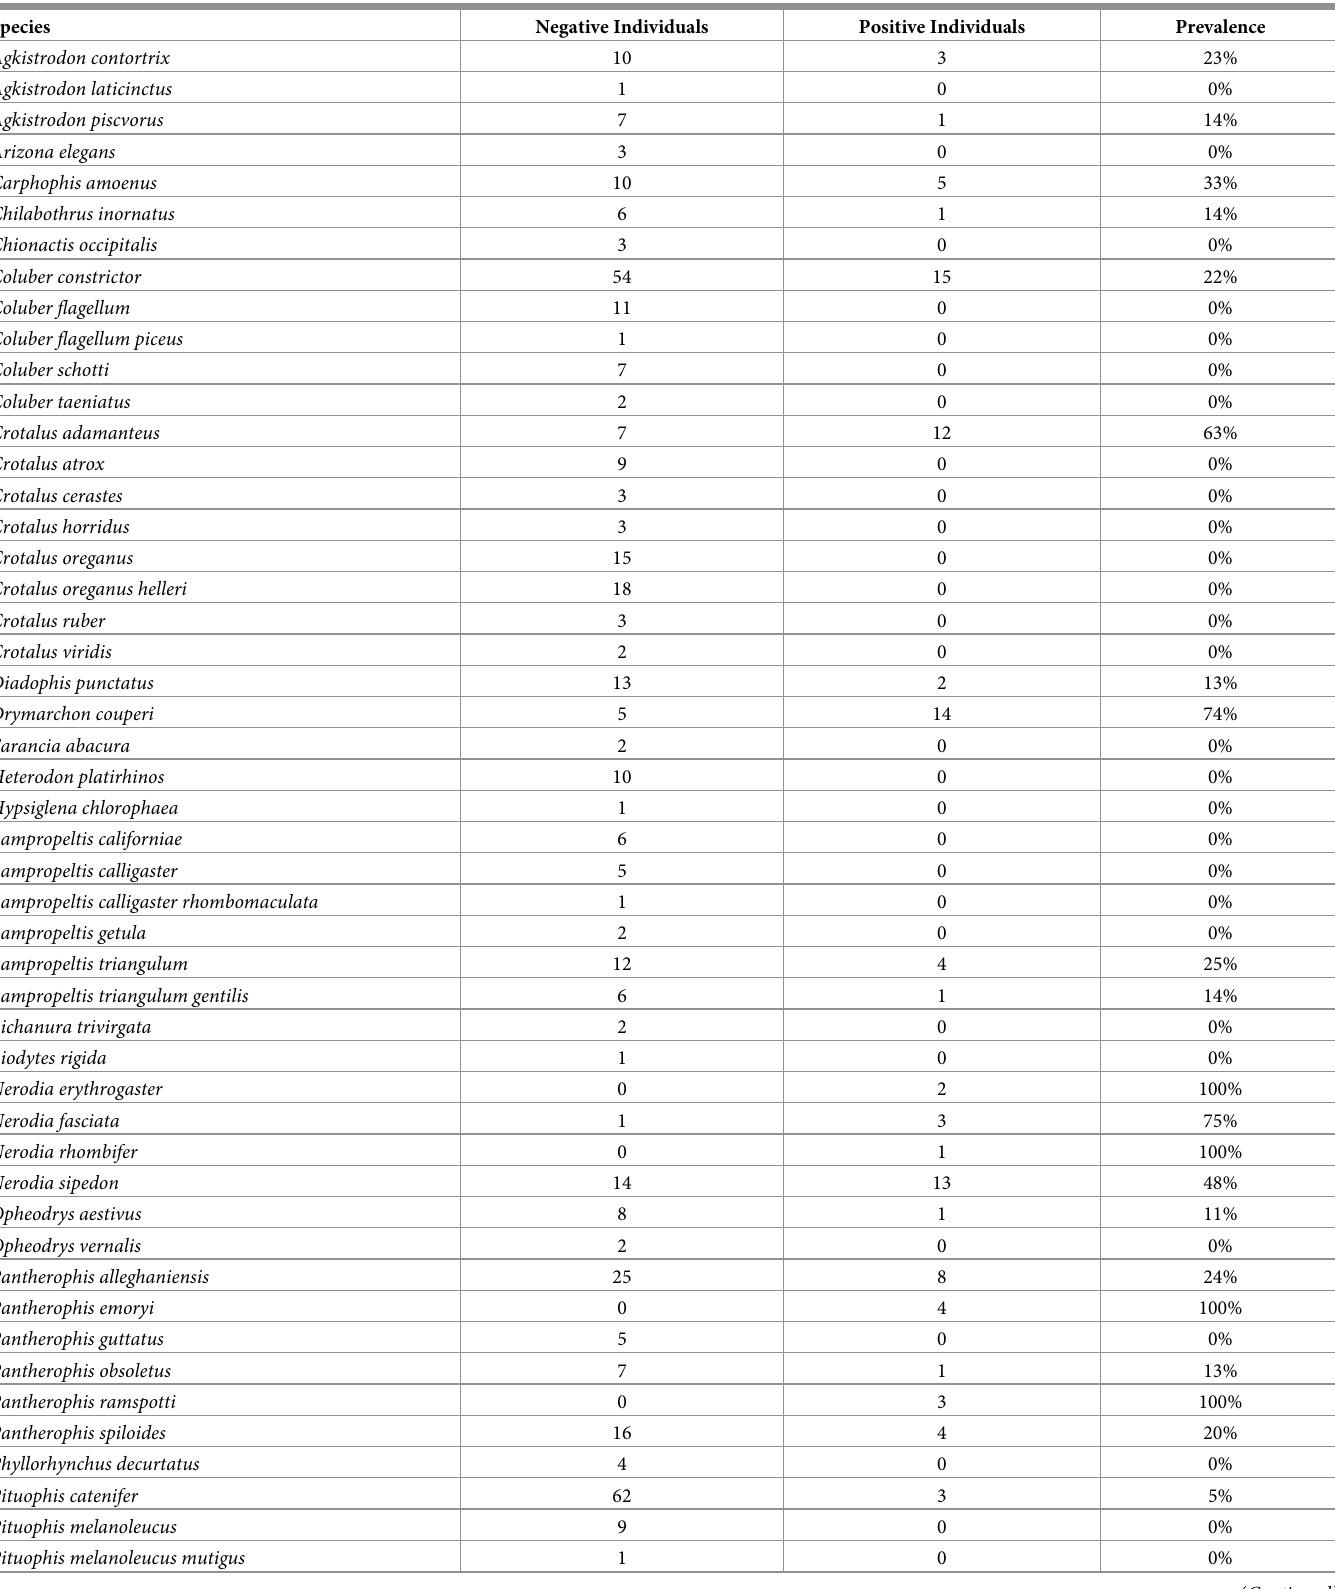
Table 1. Prevalence of Ophidiomyces ophiodiicola detected by qPCR in individual snake species on military installations in 2018.